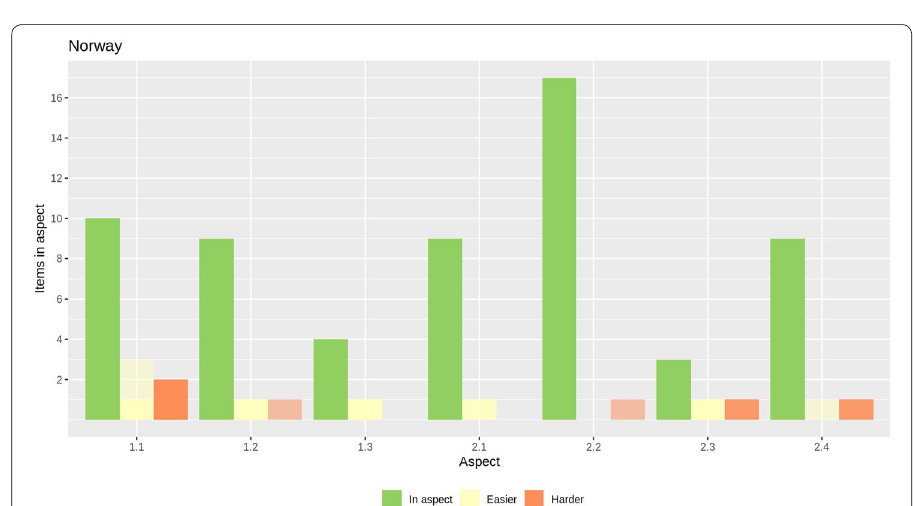
Fig. 2 Items showing DIF for Norwegian students. Green bars show how many items there are in the aspect in total. Yellow bars show the number of items having a DIF indicating that they are easier for Norwegian students at level B (darker yellow), level ICILS (medium yellow), and level C (lighter yellow). Orange bars show the number of items being harder for Norwegian students at levels B, ICILS, and